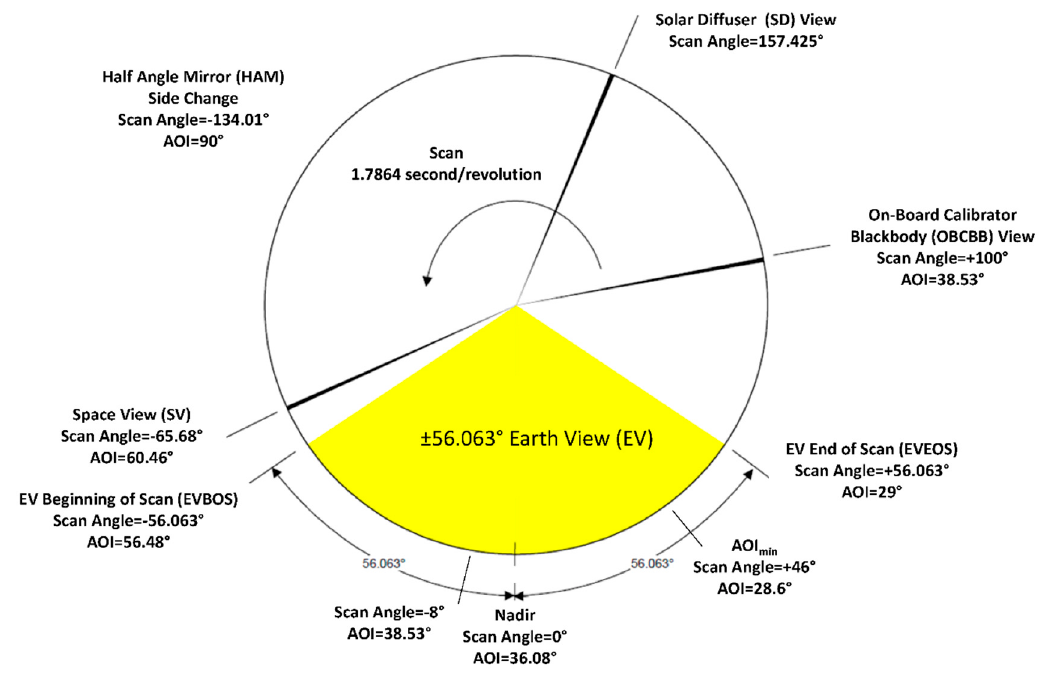
Figure 1. Diagram of Visible Infrared Imaging Radiometer Suite (VIIRS) scan pattern. Scan angles and angle of incidences (AOIs) at space view (SV), blackbody (OBCBB), the beginning of Earth View (EV) scan (EVBOS), nadir, the end of EV scan (EVEOS), and AOI min are also given.